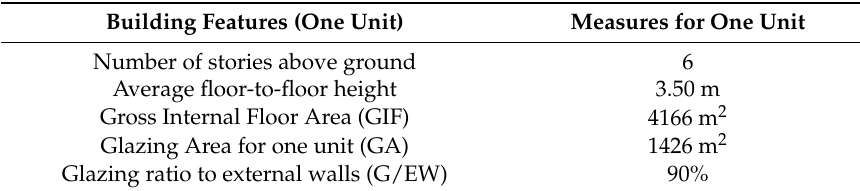
Table 5. Reference building features (one unit).